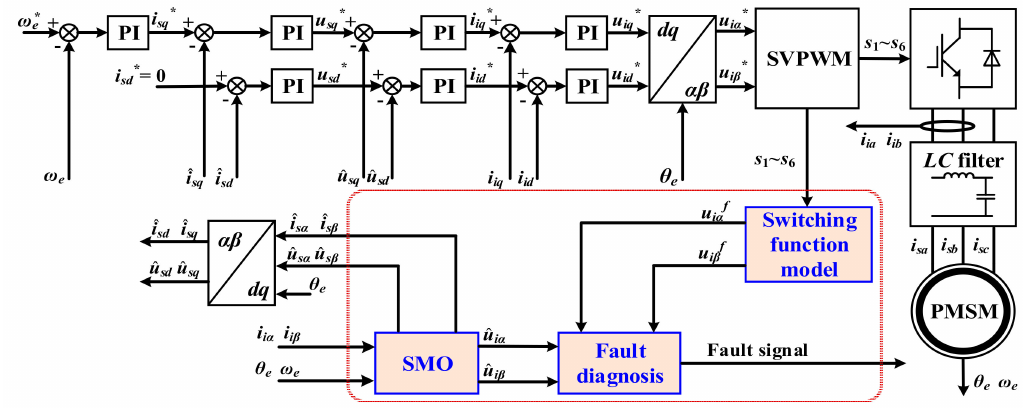
Figure 2. Overall control diagram of PMSM connected with LC